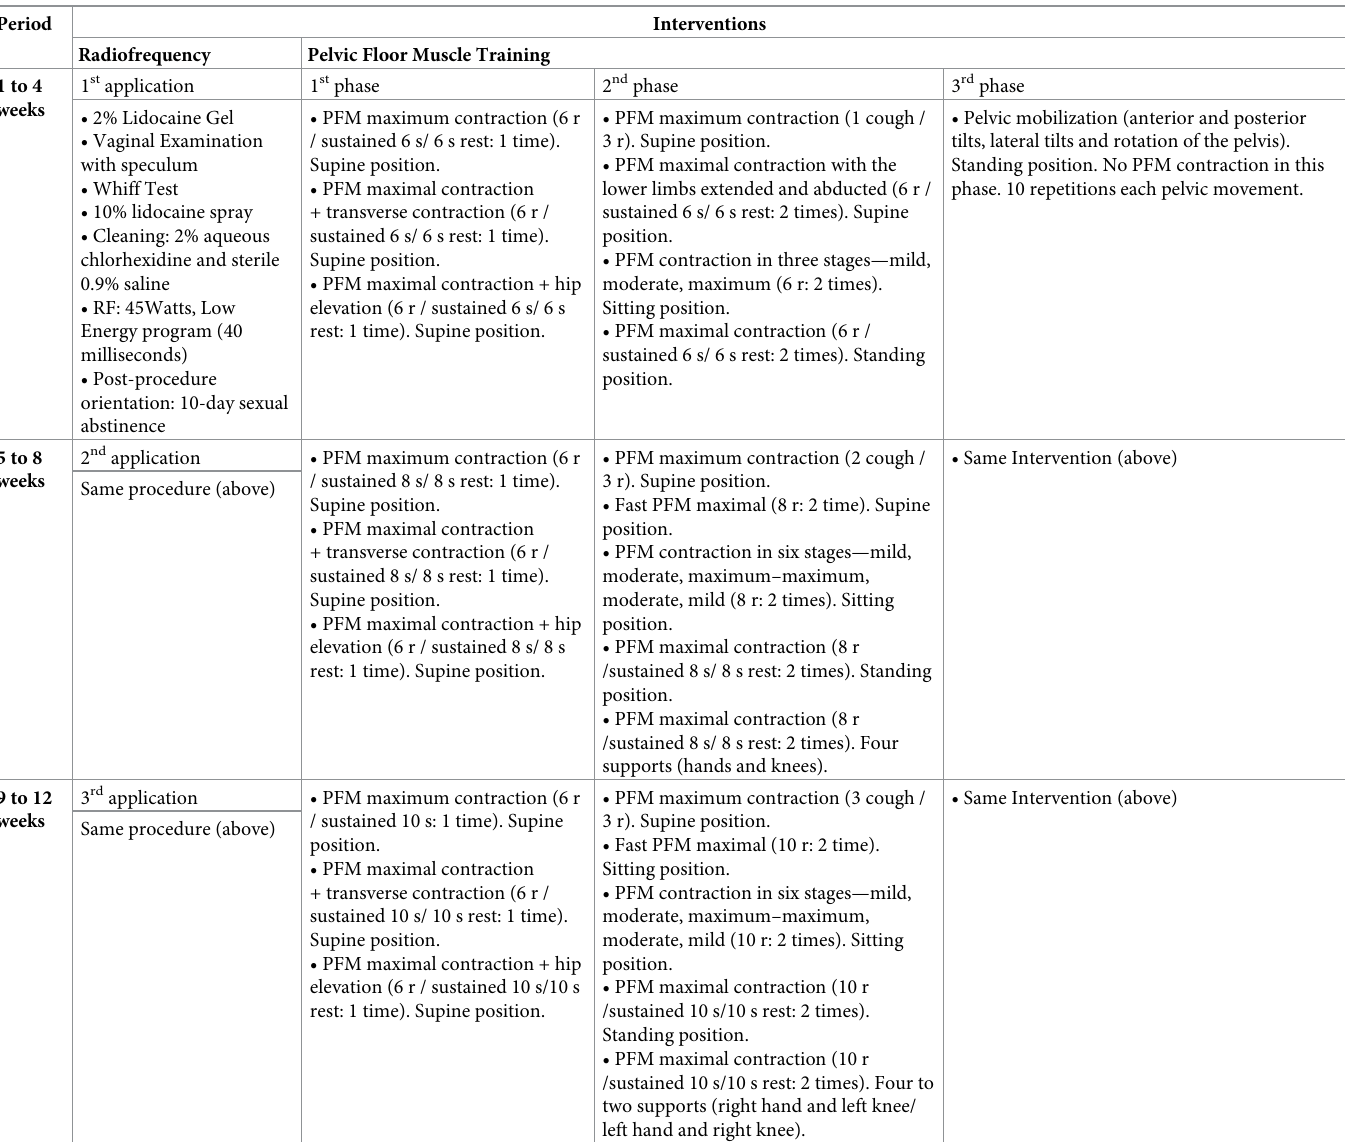
Table 1. Pelvic floor muscle training and radiofrequency sessions according to the treatment duration.